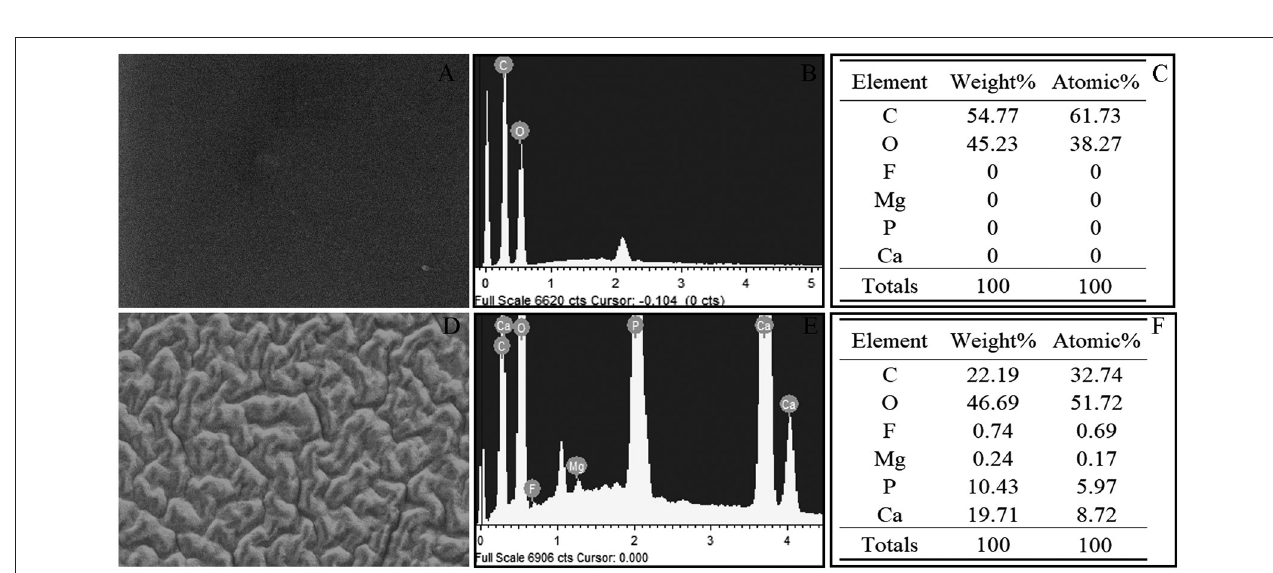
FIGURE 2 | Energy Dispersive X-ray Spectral from case 4 revealed the presence of calcium and phosphorous in the turbid area of US-860 UV, but L-312 IOL (case 1) contains only carbon and oxygen. (A–C) Obtained from case 1, (D–F) obtained from case 4. C, carbon; O, oxygen; P, phosphorus; Ca, calcium; F, fluorine; and Mg,